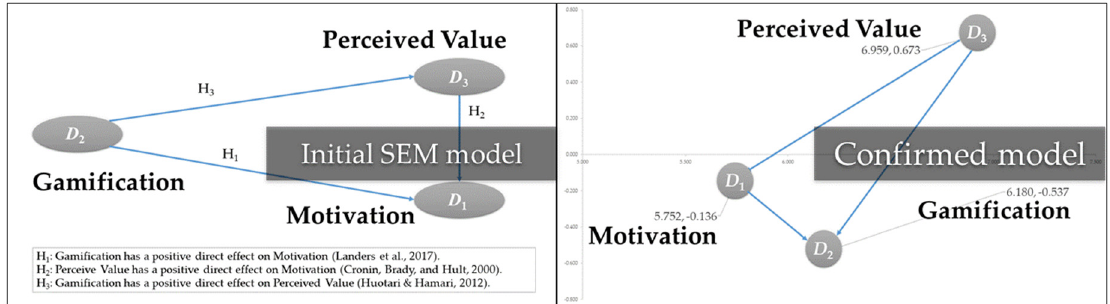
Figure 5. The initial SEM model and the INRM of dimensions.